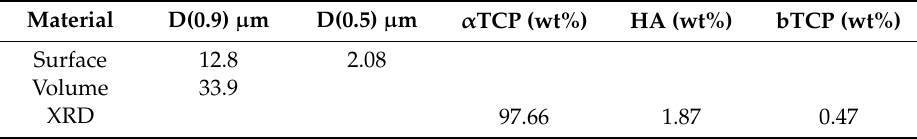
Table 2. Particle size and x-ray di ff raction (XRD)